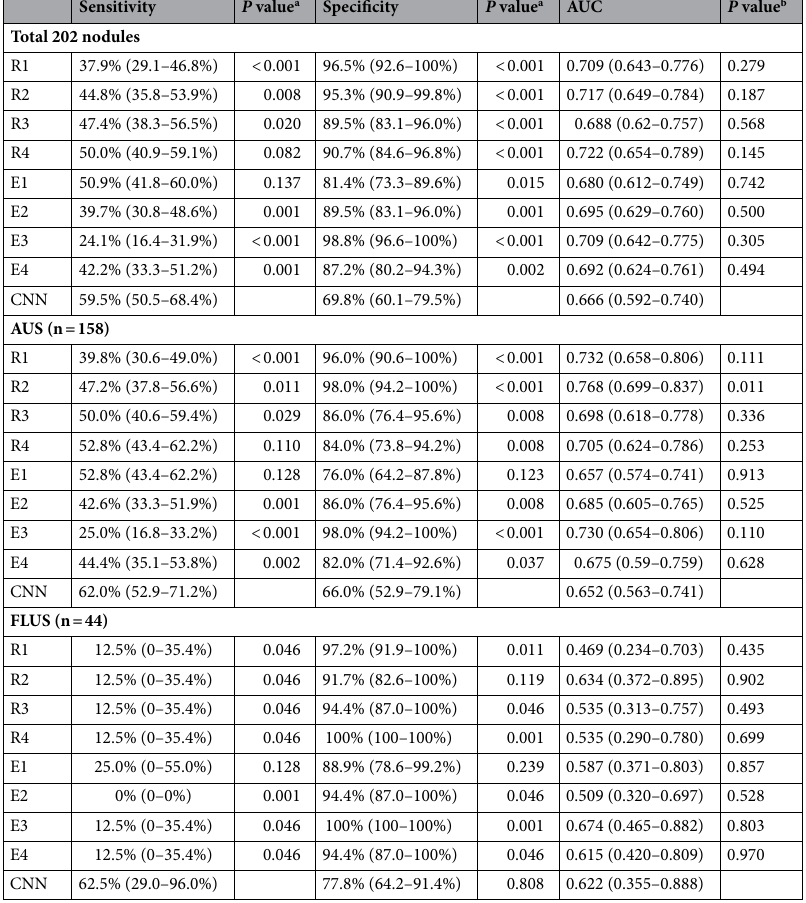
Table 3. Diagnostic performances of the 8 physicians and deep convolutional neural network. R radiologist, E endocrinologist, CNN deep convolutional neural network, AUS atypia of undetermined significance, FLUS follicular lesion of undetermined significance. a Compared with the results of the convolutional neural network (CNN) using by generalized estimating equation. b Compared with the results of the CNN using by DeLong’s